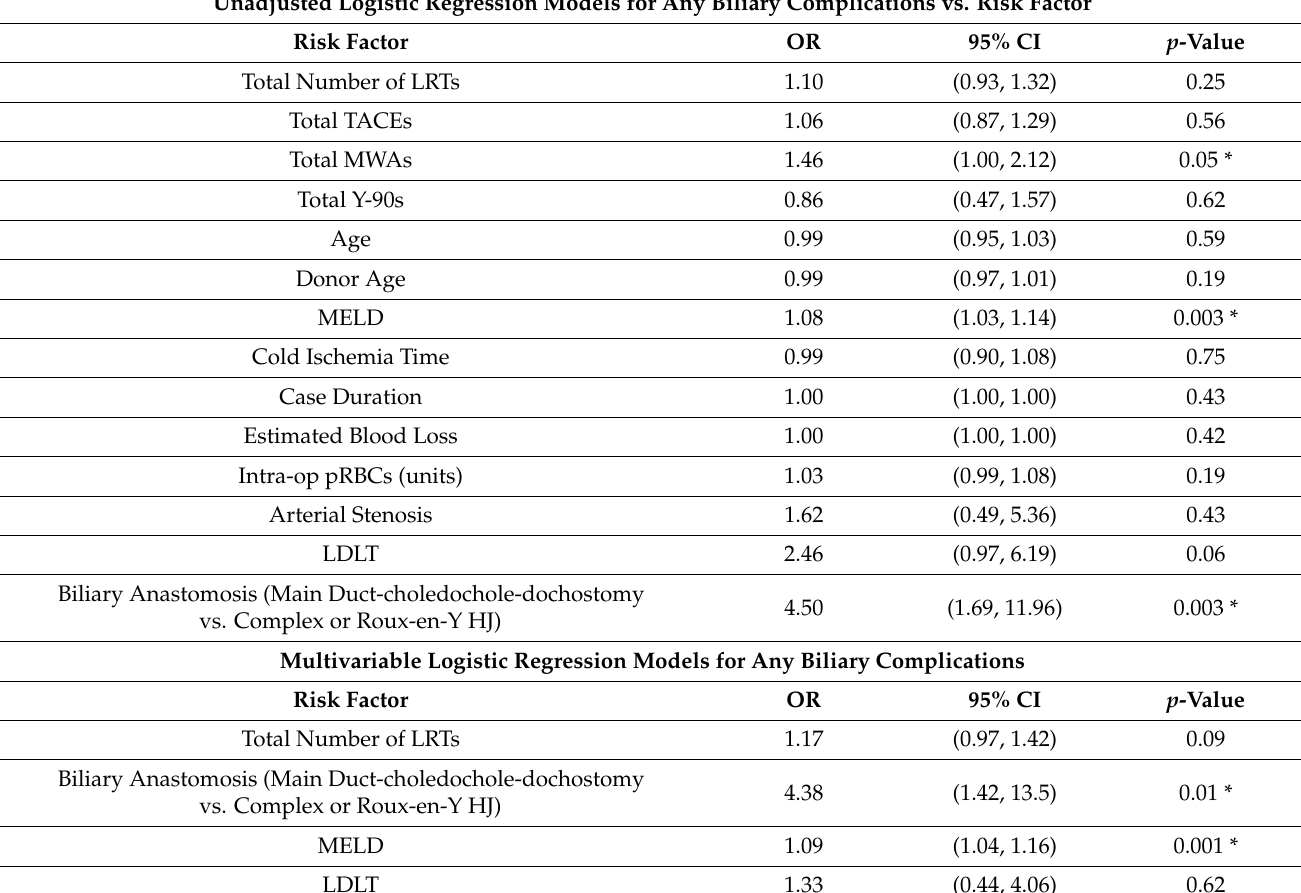
Figure 2. Prevalence of Biliary Leak for Different Type of TRL. Table 6. Logistic Regression Models for Any Biliary Complications. Unadjusted Logistic Regression Models for Any Biliary Complications vs. Risk